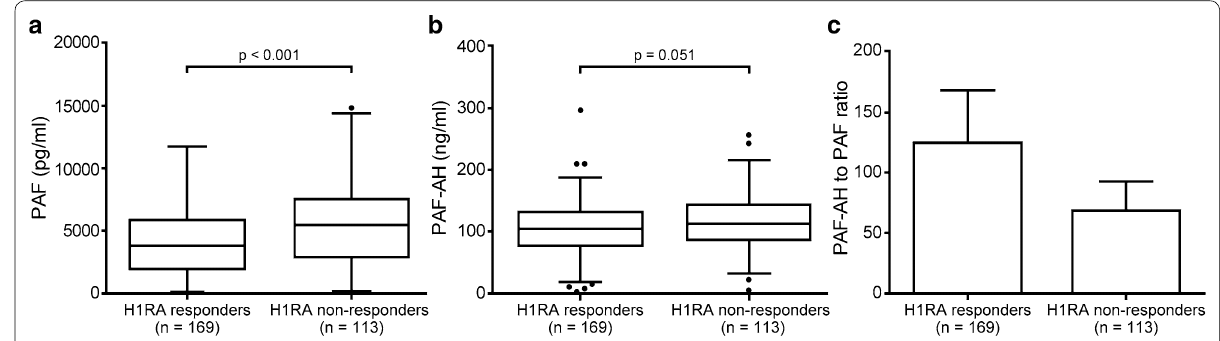
Fig. 2 Serum levels of PAF ( a ) and PAF‑AH ( b ) and PAF‑AH to PAF ratio ( c ) in H1RA responders and H1RA non‑responders among CSU patients.